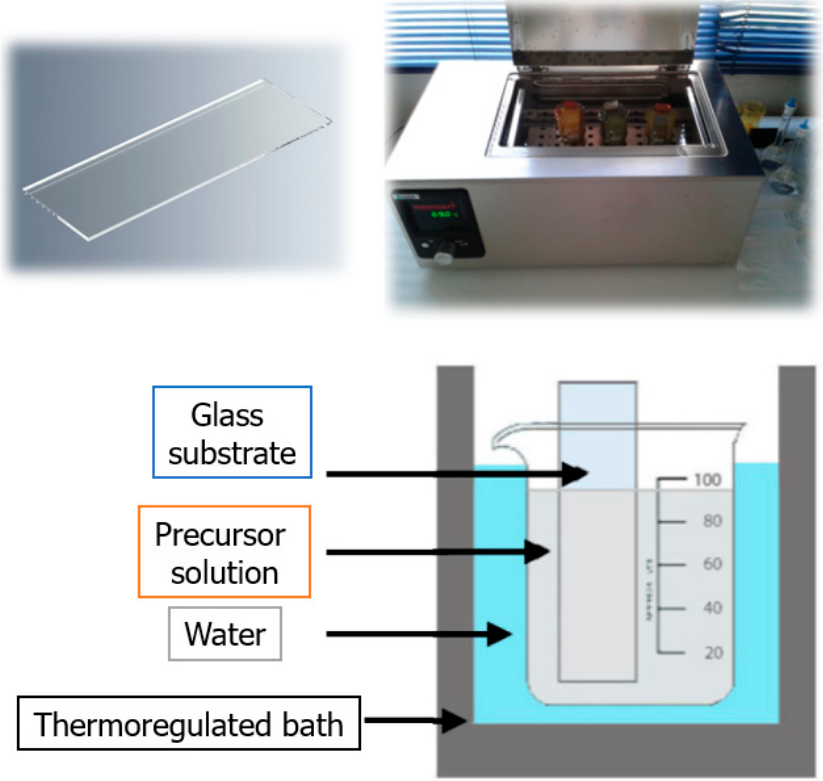
Figure 6. Schematic diagram of the synthesis process used to obtain the thin films. A glass substrate ( top left ) is placed in a thermoregulated bath ( top right ) in a precursor solution at 70 °C for 120 min. The substrate is placed vertically in the solution ( bo tt om ).